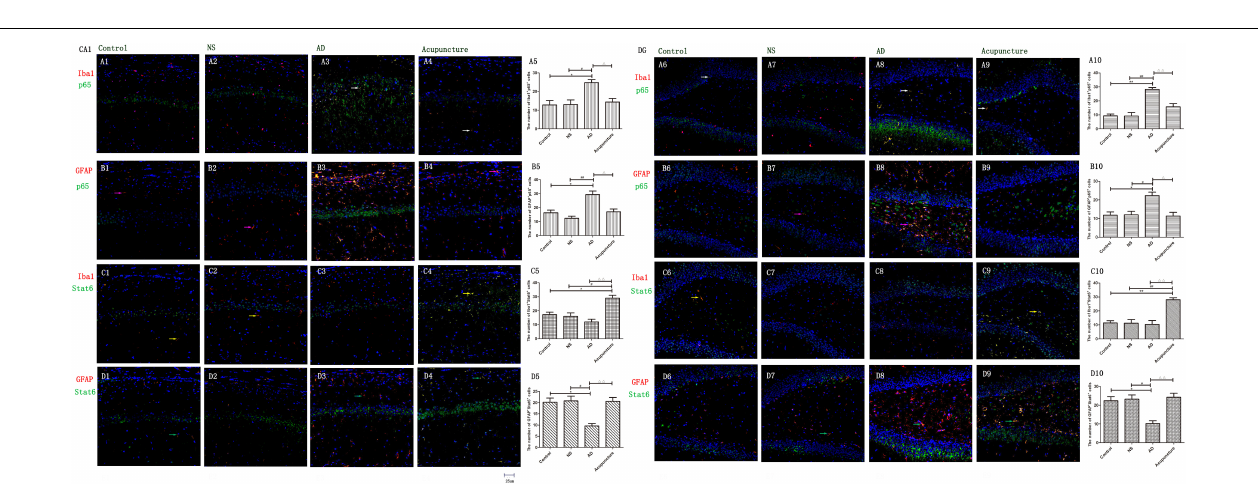
FIGURE 6 | The mRNA expression of cytokines and pathway molecules in hippocampus. (A–C) Quantitative data on the relative expression of cytokines mRNA. (A) IL-6, (B) IL-4, (C) IL-10. (D,E) Quantitative data on the relative expression of pathway molecules mRNA. (D) p65 and (E) Stat6 ( n = 5). Compared with Control group, * p < 0.05, ** p < 0.01; compared with NS group, ## p < 0.01; compared with AD group, (cid:77)(cid:77) p < 0.01.